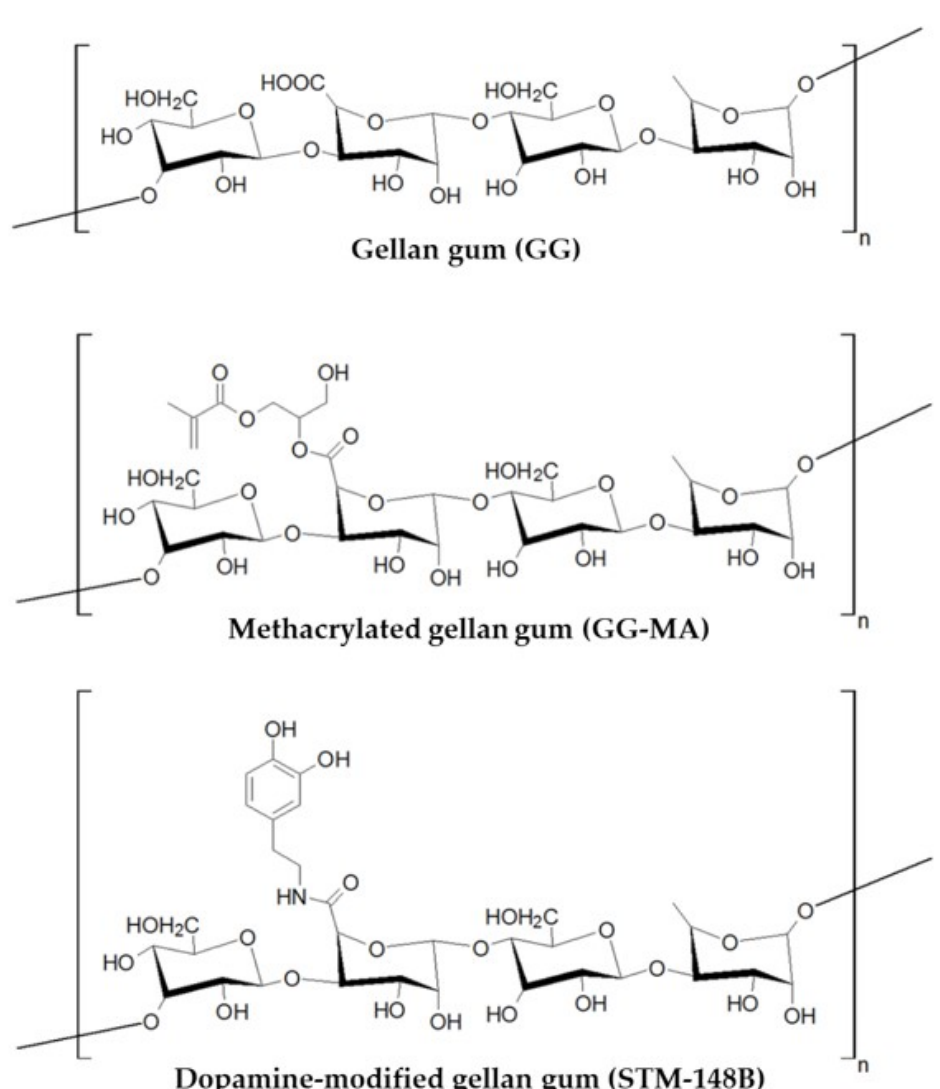
Figure 1. Chemical structure of the tetrasaccharide repeat unit of GG, its semi-synthetic derivative GG-MA and dopamine-modified GG